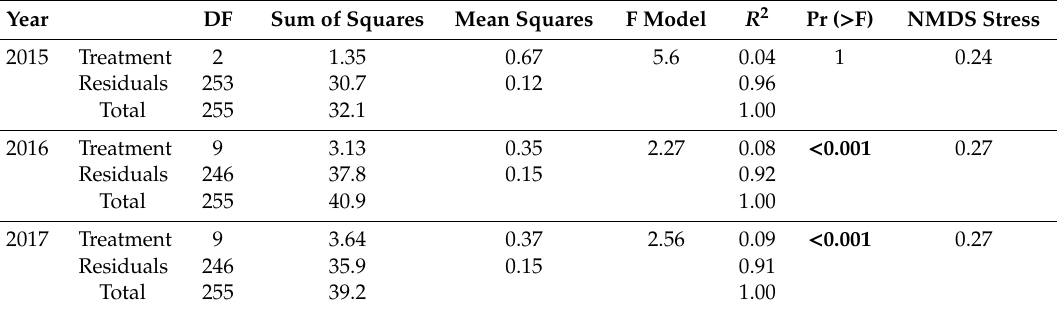
Table 8. Treatment e ff ects on plant community structure. Results based on non-metric multidimensional scaling (NMDS) and the distance matrix of plant species abundances. Model summary is from the package “adonis” in R and stress is provided by the NMDS analysis. DF Sum of Squares Mean Squares F Model